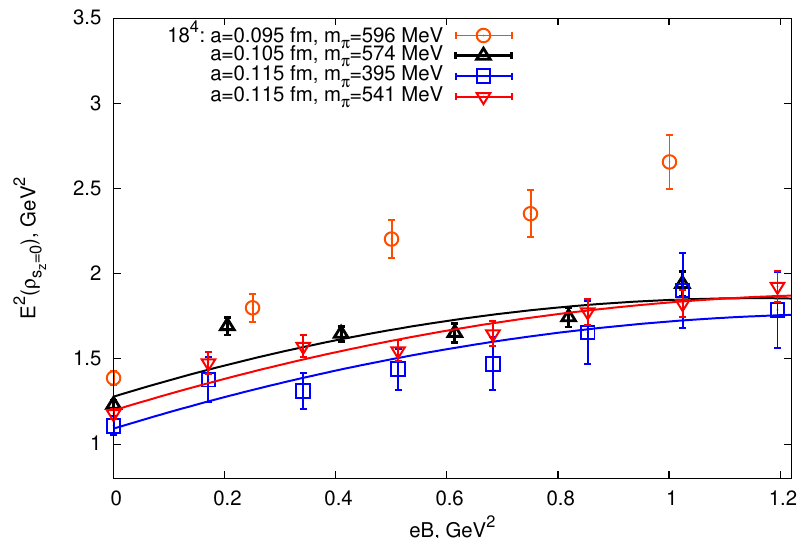
Figure 2 . The energy squared of the charged (cid:26) meson for the projection s z = 0 depending on the magnetic (cid:12)eld value for various lattice sets of data. The solid lines correspond to the (cid:12)ts of the lattice data obtained with the use of formula